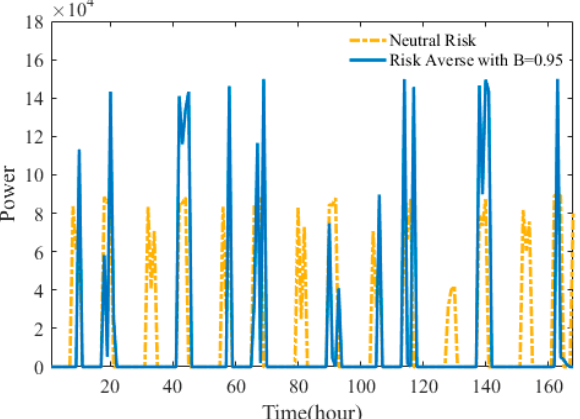
Figure 11. Transferred power from the PV to the storage.